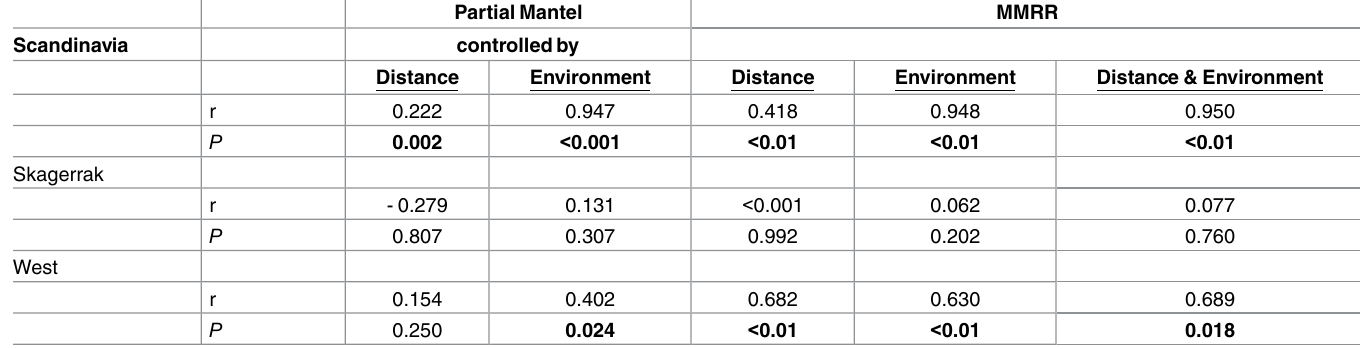
Table 4. Resultsof the partialManteltestsand MMRRanalysis comparing the contribution of geographical(IBD)and environmentaldistance (IBE)to geneticdifferentiationfor the wholeScandinavia, and separatelyfor southern(Skagerrak) and West coastsamples. r = coefficient of correla- tion, P = P -values (significant values in